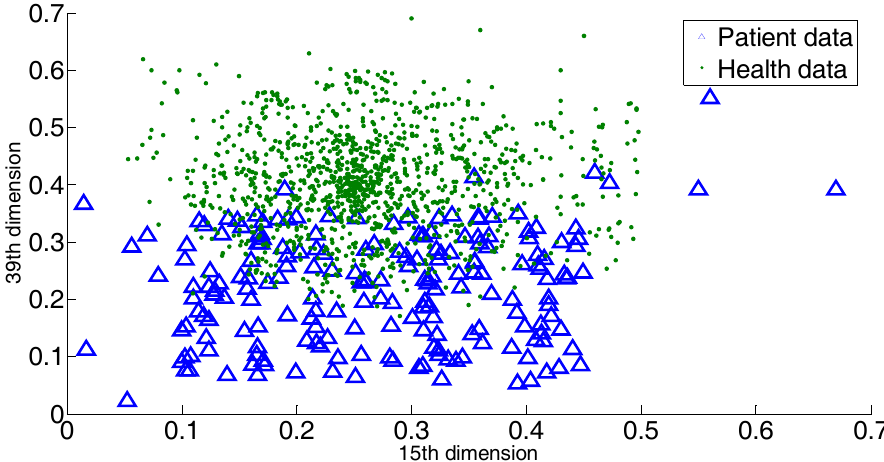
Figure 1. 2 dimensions of all the dimensions to briefly show the outliers or overlaps in the atrial hypertrophy datasets.